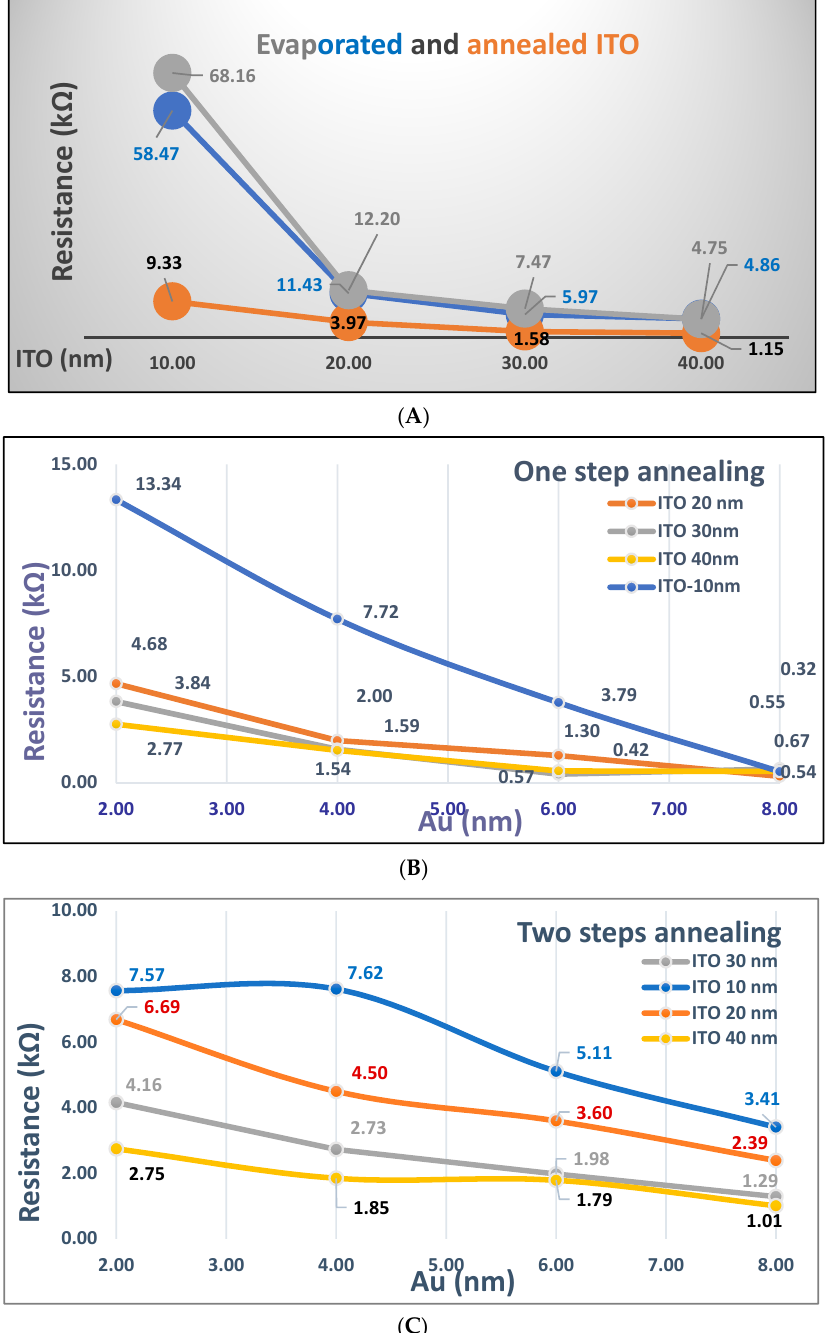
Figure 4. Resistance variation versus (i) ITO thicknesses before and after one-step and two-step annealing processes ( A ), (ii) Au thickness after one-step annealing ( B ) and Au thickness after two-step annealing ( C ) at 500 °C.